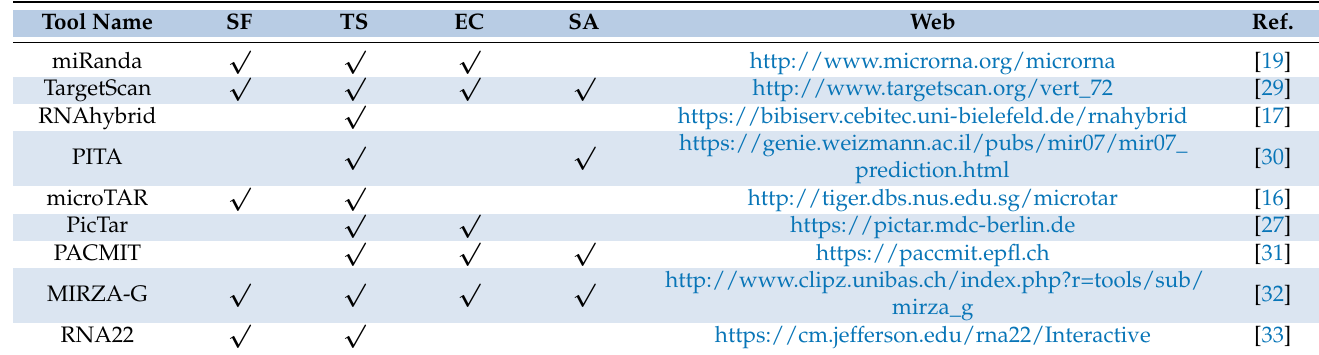
Table 1. List of miRNA target prediction tools and used strategies. SF: Sequence Features; TS: Thermo-Stability; EC: Evolutionary Conservation; SA: Site